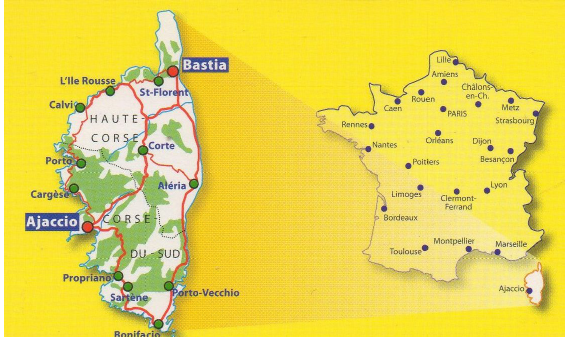
Figure 3: Corse in France